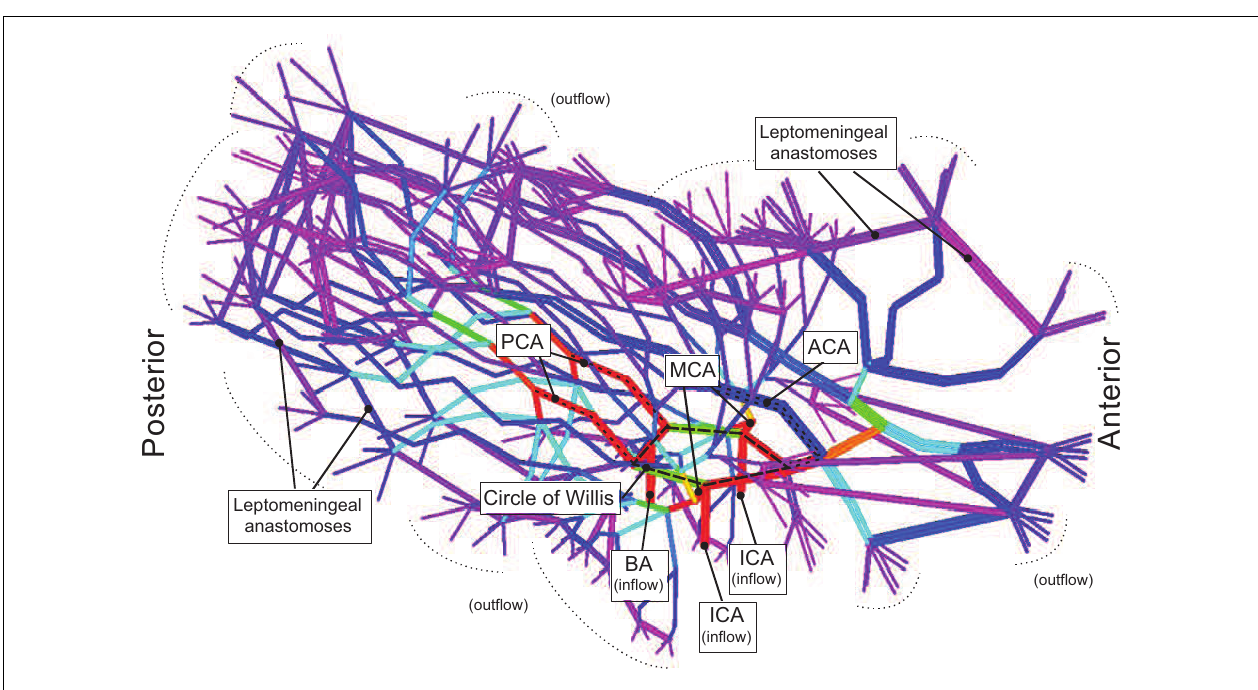
FIGURE 2 | Model of the Circle ofWillis branching into the major arteries and the leptomeningeal arteries is shown .The color of the branches represents flow rate where red describes high flow rate, and blue describes low flow rate.The Circle ofWillis (red) can be seen as the pentagon at the base of the